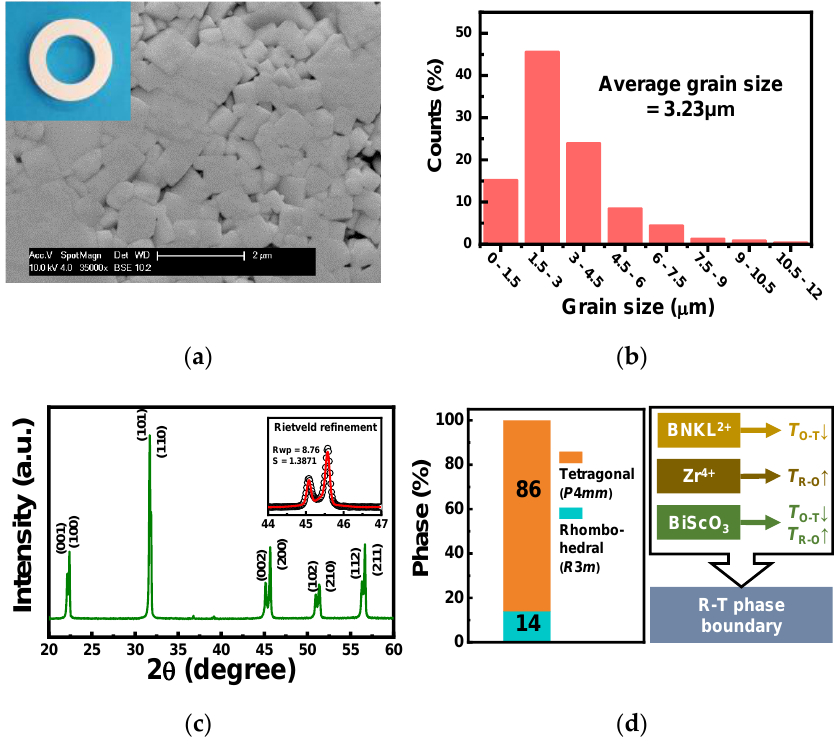
Figure 2. ( a ) Thermally etched SEM image showing the typical microstructure of a sintered KNN- BNKLZ-BS ceramic ring (the inset is a photo of a ceramic ring ready to be assembled into a sensor prototype). ( b ) Grain size distribution. ( c ) Normal θ –2 θ XRD pattern (inset is a Rietveld refinement pattern; the low-reliability factor value R wp (= 8.76%) as well as the goodness-of-fit indicator S (= 1.3871) close to 1 suggest the reliability of the refinement). ( d ) Quantitative phase fraction obtained by Rietveld refinement. The room-temperature values of static d 33 and large-signal d 33* (= S max / E max ) of the Table 1. Material properties of KNN-BNKLZ-BS and PZT ceramic rings. Material Property KNN-BNKLZ-BS